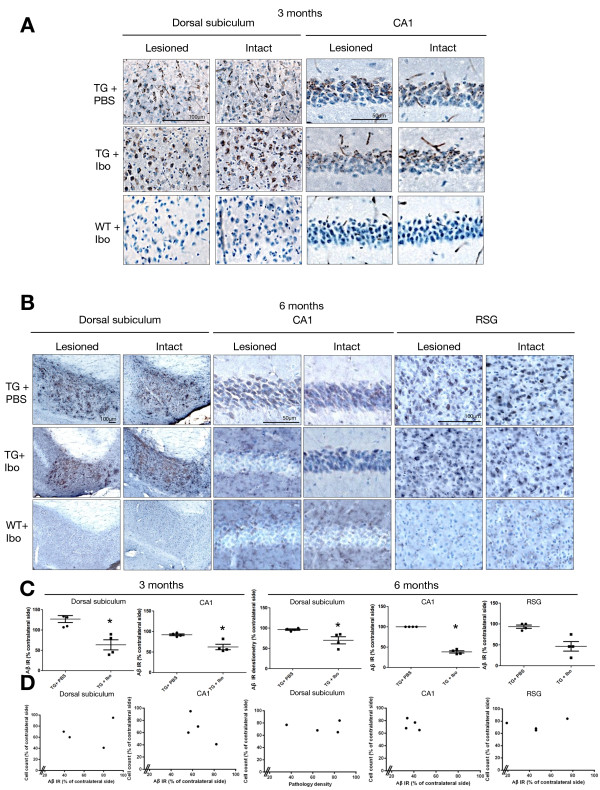
Aβ/C99 immunoreactivity in dorsal subiculum, CA1 and RSG of Tg APParc mice that have undergone partial destruction of the subiculum. A. Tg APParc mice aged 3 months comparing lesioned and intact hemispheres in the dorsal subiculum and CA1 of Tg mice injected with PBS (TG + PBS), Tg mice injected with ibotenic acid (TG + Ibo) and WT mice injected with ibotenic acid (WT + Ibo). We observed decreased Aβ pathology in both the dorsal subiculum and CA1 in Tg mice injected with ibotenic acid (Tg + Ibo). B. Aβ/C99 immunoreactivity in dorsal subiculum, CA1 and RSG of lesioned Tg APParc mice aged 6 months. Tg mice with ibotenic acid lesions have decreased Aβ/C99 immunoreactivity in the dorsal subiculum, CA1 and RSG. C. Quantification of the Aβ/C99 immunoreactivity comparing Aβ/C99 immunoreactivity (Aβ IR) in the lesioned hemisphere as a percentage of the contralateral side. Tg mice with ibotenic acid lesions have significantly decreased Aβ/C99 immunoreactivity in the damaged hemisphere in the dorsal subiculum and CA1 at ages 3 and 6 months. D. Plots representing cell count in the subiculum (percentage of contralateral side) vs. Aβ/C99 immunoreactivity in Tg + Ibo animals for the dorsal subiculum, CA1 and RSG of mice aged 3 and 6 months. Plots indicate a no correlation, rs = 0.2, p > 0.05 (3 and 6 months dorsal subiculum, CA1 and RSG). Data expressed as means ± SEM. Asterisk denotes statistical significance (*p < 0.05).